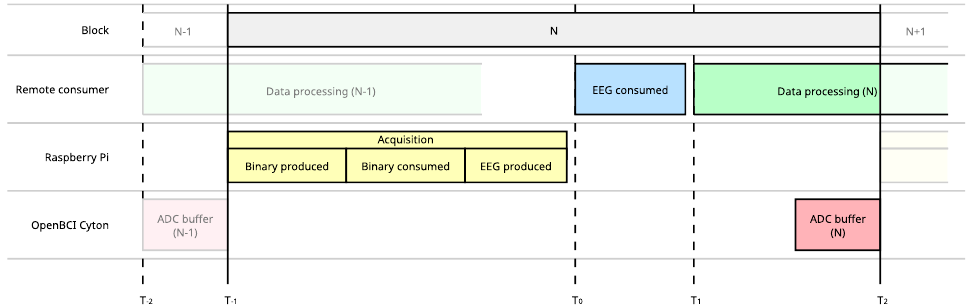
the EEG data, and the remaining ones, e.g., 26 to 32, gather the auxiliary data.